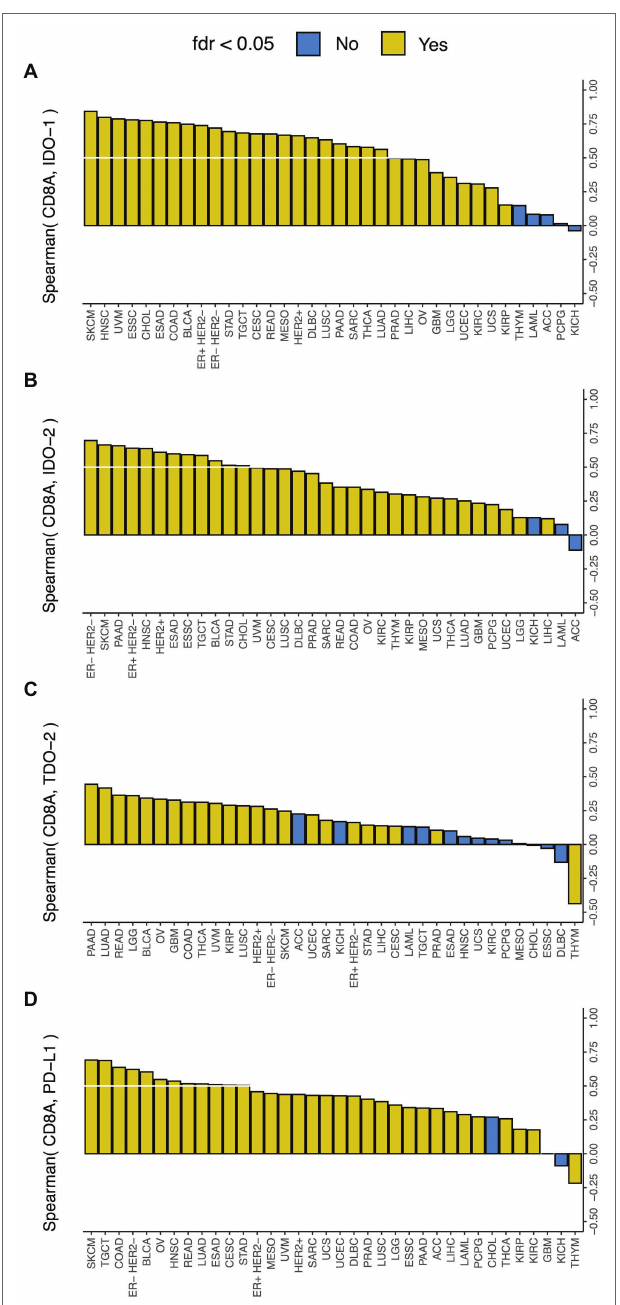
FIGURE 2 | Correlation between IDO pathway expression and CD8A expression. Correlation between expressions of CD8A and (A) IDO-1 , (B) IDO-2 , (C) TDO-2 , and (D) PD-L1 (the white lines mark Spearman Rho = 0.5). Cancer type acronyms are standard TCGA abbreviations (https:// gdc.cancer.gov/resources-tcga-users/tcga-code-tables/tcga-study- abbreviations). FDR, false discovery rate. ESAD, esophageal adenocarcinoma; ESSC, esophageal squamous cell